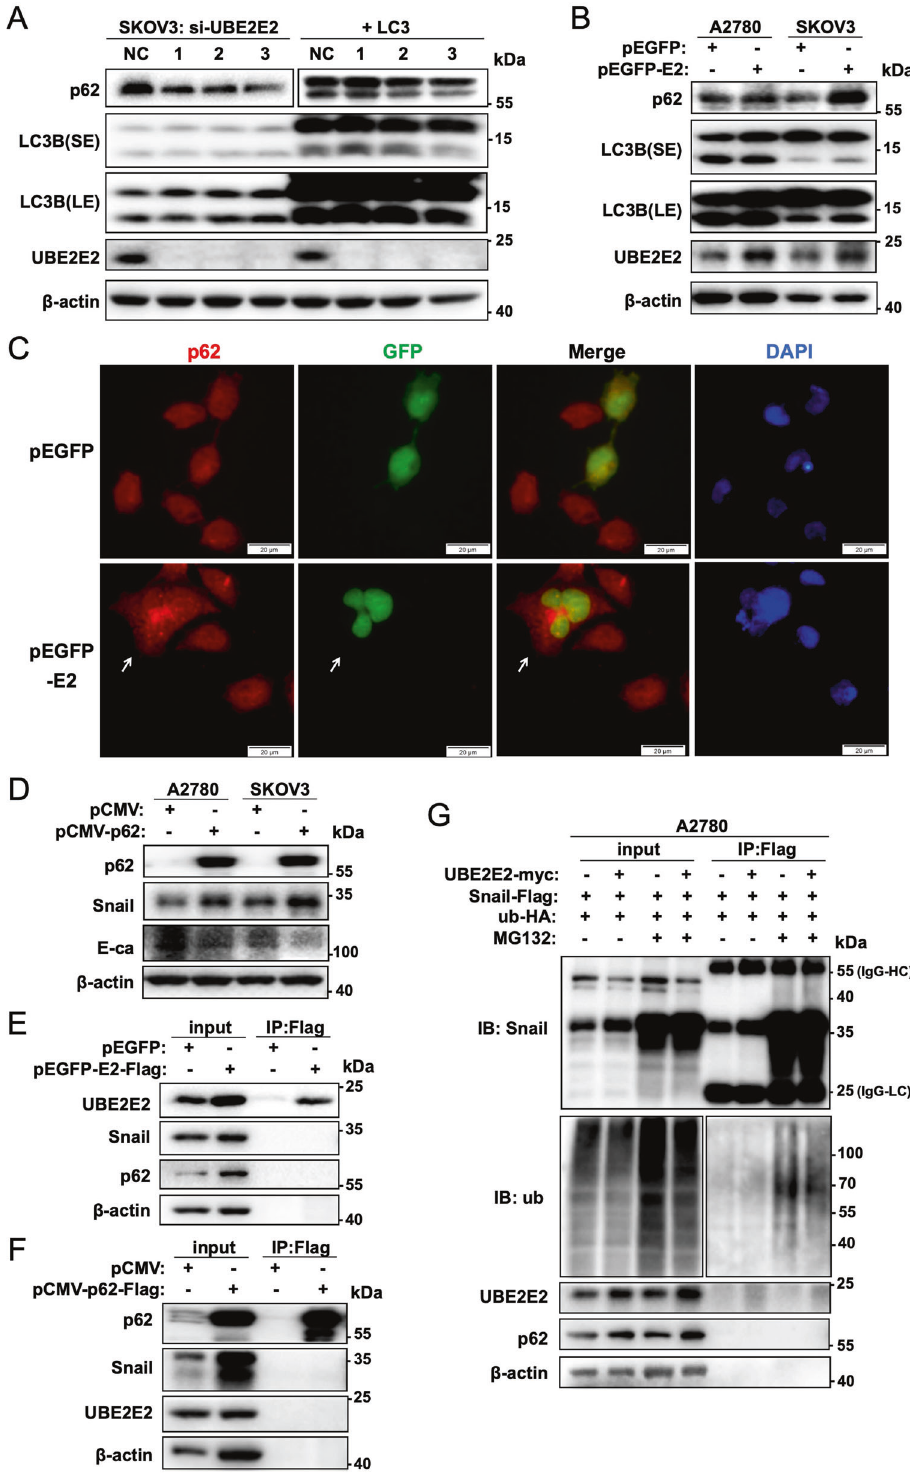
Fig. 4 UBE2E2 enhances p62 expression and Snail stability. A , B The expression of p62, LC3B and UBE2E2 was explored by western blot analysis performed 72 h after cell transfection with UBE2E2 siRNA or overexpression vector. SKOV3 cells were infected with adenoviral particles that directed the expression of mRFP-GFP-LC3, incubated for 24 h and subjected to western blot analysis (SE, short exposure, and LE, long exposure). C The changes in p62 expression were assessed by SKOV3 cell immuno fl uorescence staining. An overlay of red (p62) and green (GFP) channels is shown. White arrows indicate the transfected cells (scale bar = 20 μ m). D The expression of EMT markers was explored by western blotting performed 72 h after transfection with the p62-expressing vector or control vector. E , F Immunoprecipitation (IP) of Flag-tagged UBE2E2 and p62 in A2780 cells. G Immunoprecipitation (IP) assays were performed to detect the ubiquitination of Snail in A2780 cells 72 h after transfection with the plasmids as shown. MG132, which is used to block the proteasome system, was added to the cultures ( fi nal concentration of 10 μ M) 12 h prior to cell harvesting. The IgG heavy chain (55-kDa band) and light chain (25-kDa band) were used as markers. Cell Death and Disease (2023)